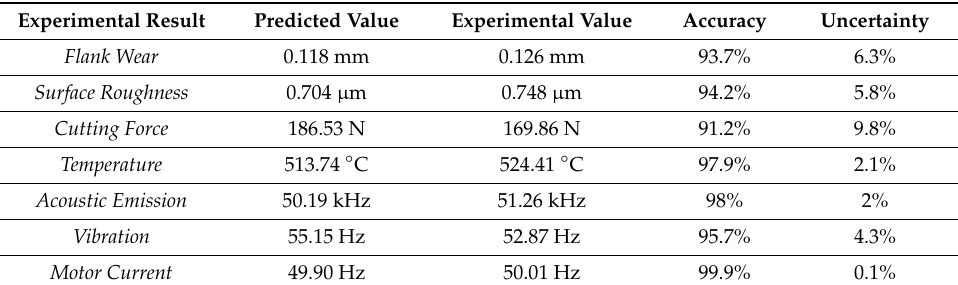
Table 8. Comparison of experimental and predicted results for all variables.